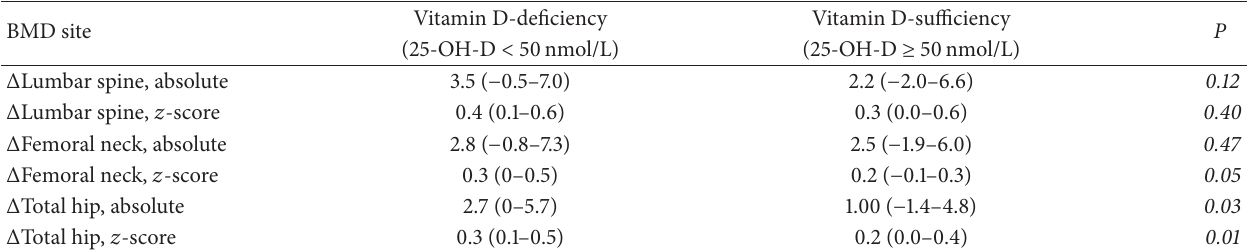
Table 5: Bone remineralisation after operation for primary hyperparathyroidism in patients with or without vitamin D deficiency (25-OH-D < 50nmol/L). Change in absolute values in percent. Change in 𝑧 -score in arithmetic difference. Medians (IQR). Kruskal-Wallis